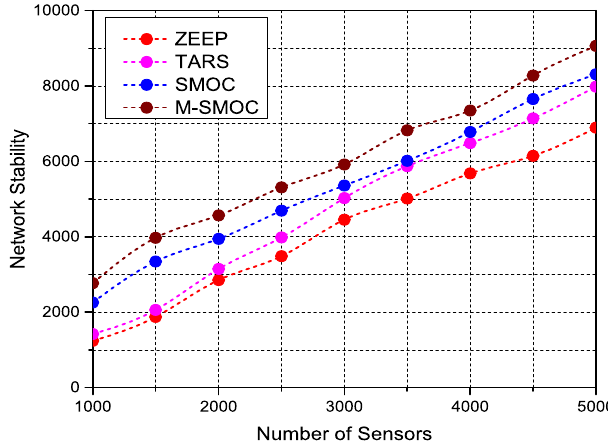
Figure 13. Comparison of the network stability with various numbers of sensors in the network.